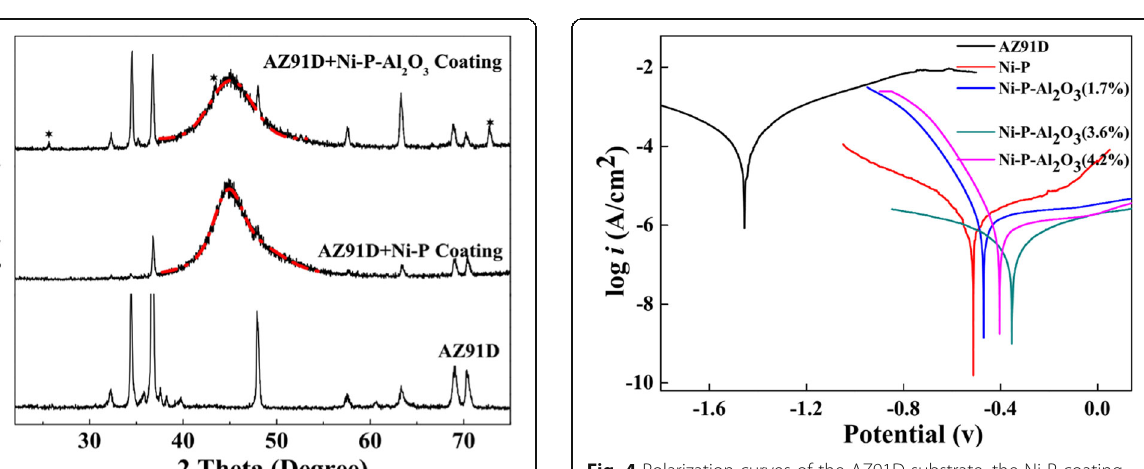
Fig. 4 Polarization curves of the AZ91D substrate, the Ni-P coating, and the Ni-P-Al 2 O 3 composite coatings